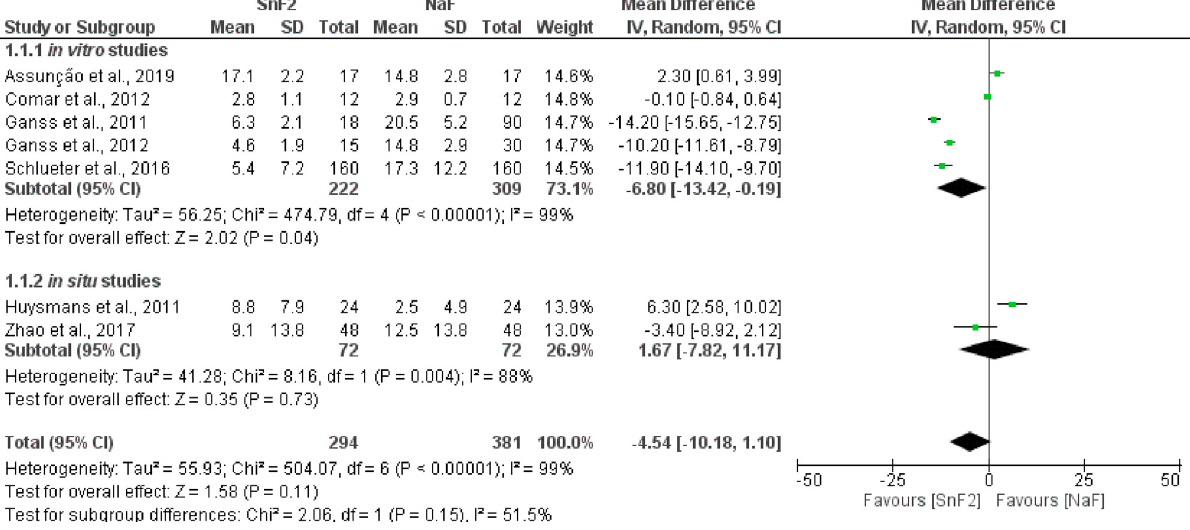
-containing dentifrices versus NaF-containing dentifrices. 2